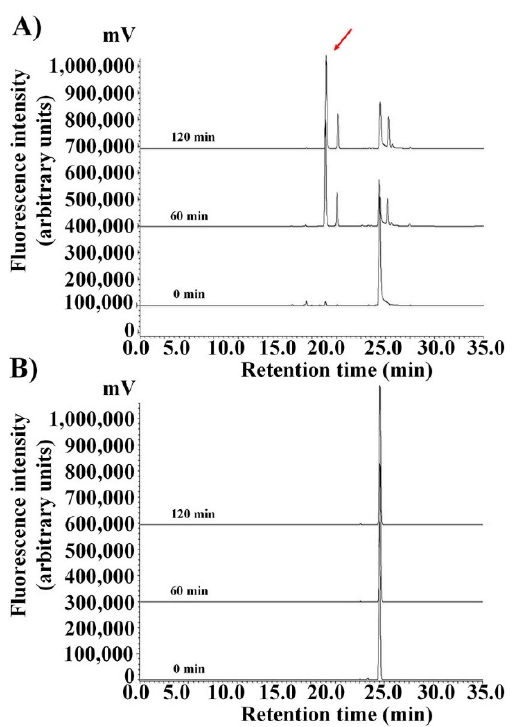
Figure 4. Stability of TAMRA-HPA3NT3-A2 ( A ) and TAMRA-HPA3NT3-A2D ( B ) against proteolytic degradation in 50% serum. HPLC profiles of TAMRA-peptides after different incubation times (0, 60, 120 min) at 37 °C in serum are shown. Arrow indicates the fragment of peptide cleaved. Moreover, the antibacterial activities of serum were evaluated to the MICs against E. coli and S. aureus (Figure 5).